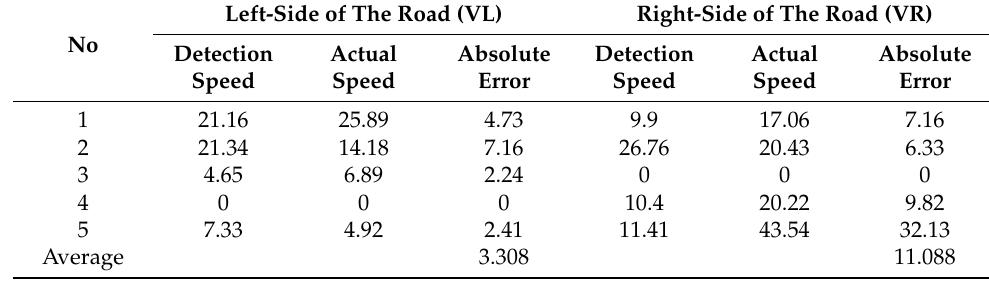
Table 9. Absolute error (km/h) for vehicle speed calculation on Pramuka–Cihapit road segment.